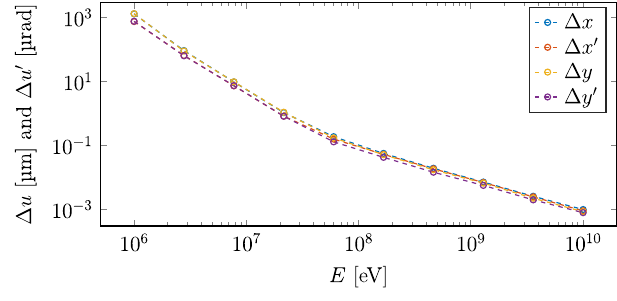
FIG. 10. Comparison between the linear beam dynamics model [cf. Eq. (22)] and ASTRA for different initial beam energies E . Plotted are the rms differences ½ Δ x; Δ x 0 ; Δ y; Δ y 0 (cid:3) for 10 4 particles at different rf amplitudes and